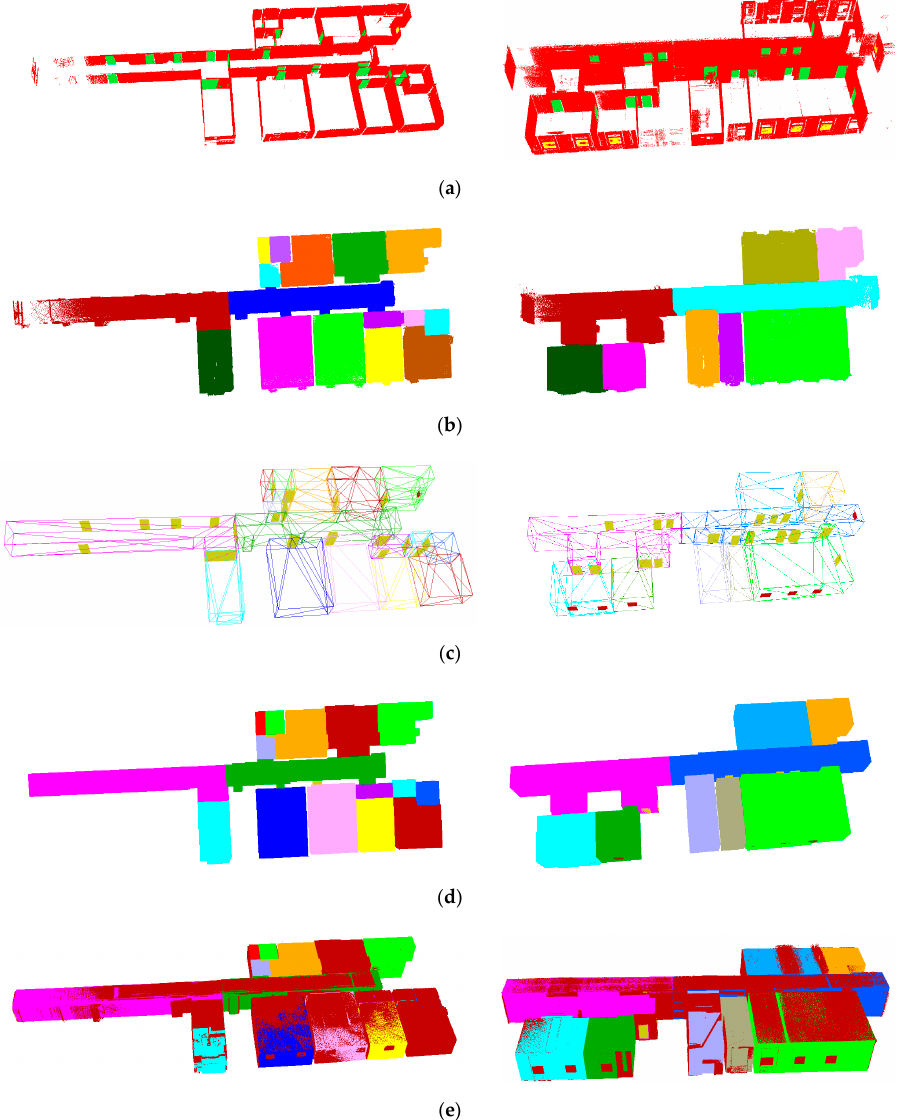
Figure 17. Opening extraction, room segmentation, structural model and wireframe model results with the benchmark point clouds. ( a ) Doors (green) and windows (yellow) of the first and the second floors. ( b ) Segmented rooms of the first and second floors. ( c ) The structural models with doors and windows of the first and the second floors. ( d ) The wireframe models with doors and windows of the first and second floors. ( e ) Matching between the point clouds and the structured models on the first and second